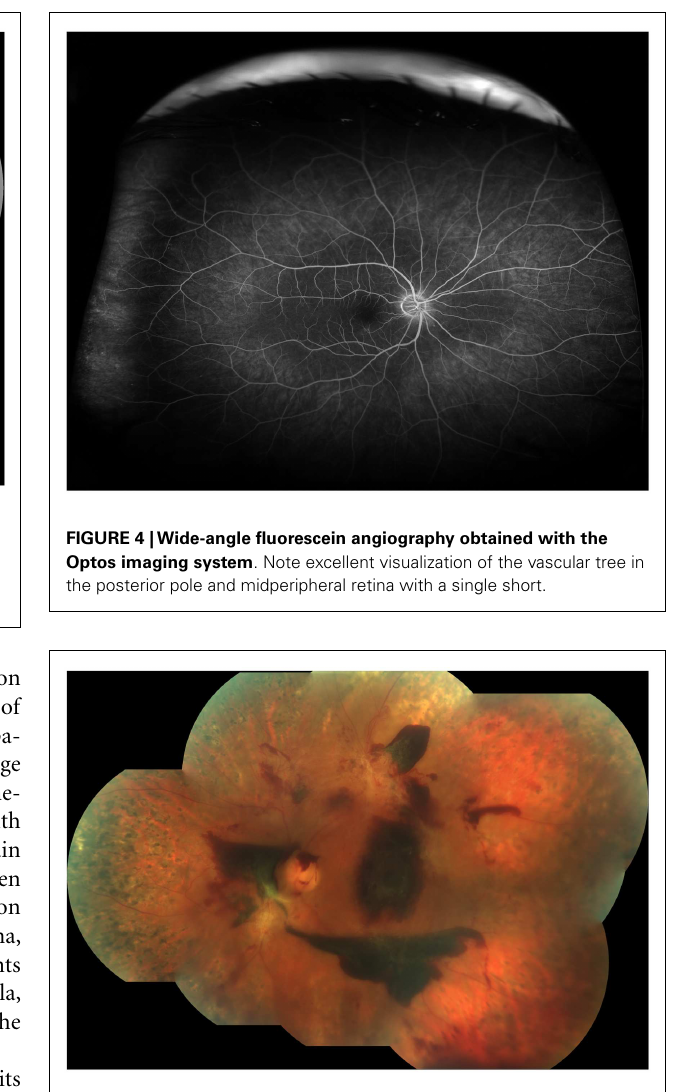
FIGURE 5 | Fundus photograph obtained from the left eye of a patient with proliferative diabetic retinopathy who had undergone laser panretinal photocoagulation (PRP) . Despite a complete PRP, active disease was still present, as demonstrated by the presence of still viable neovascularization and extensive sub-hyaloid, pre-retinal hemorrhages. Note the large pre-retinal hemorrhage covering the